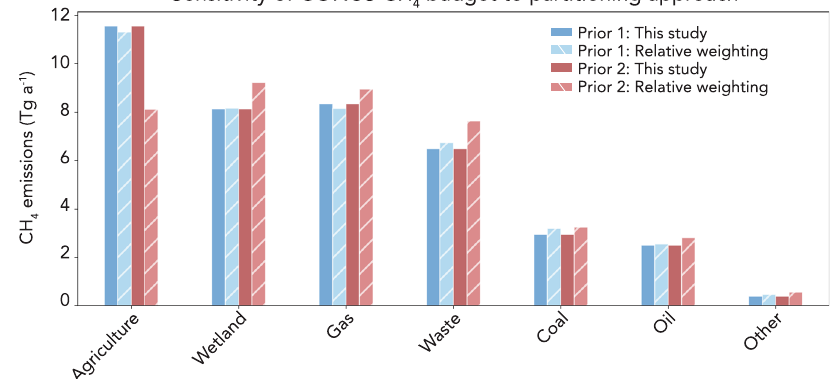
Fig. 2 Emissions partitioned or optimized from 2010 – 2015 GOSAT fl ux inversions. Two different fl ux products are partitioned using two different partitioning approaches. Blue bars represent fl uxes that were derived using the same fl ux prior as Fig. 1 (Table S1). Red bars represent fl uxes that were derived using EDGAR v5.0 for oil, gas, livestock, and waste sectors. Solid bars represent the optimal emission (OE) approach from Eqs. 1 – 2. Hatched bars represent partitioning done by computing the relative weights (RW) of emission sectors that made up the fl ux